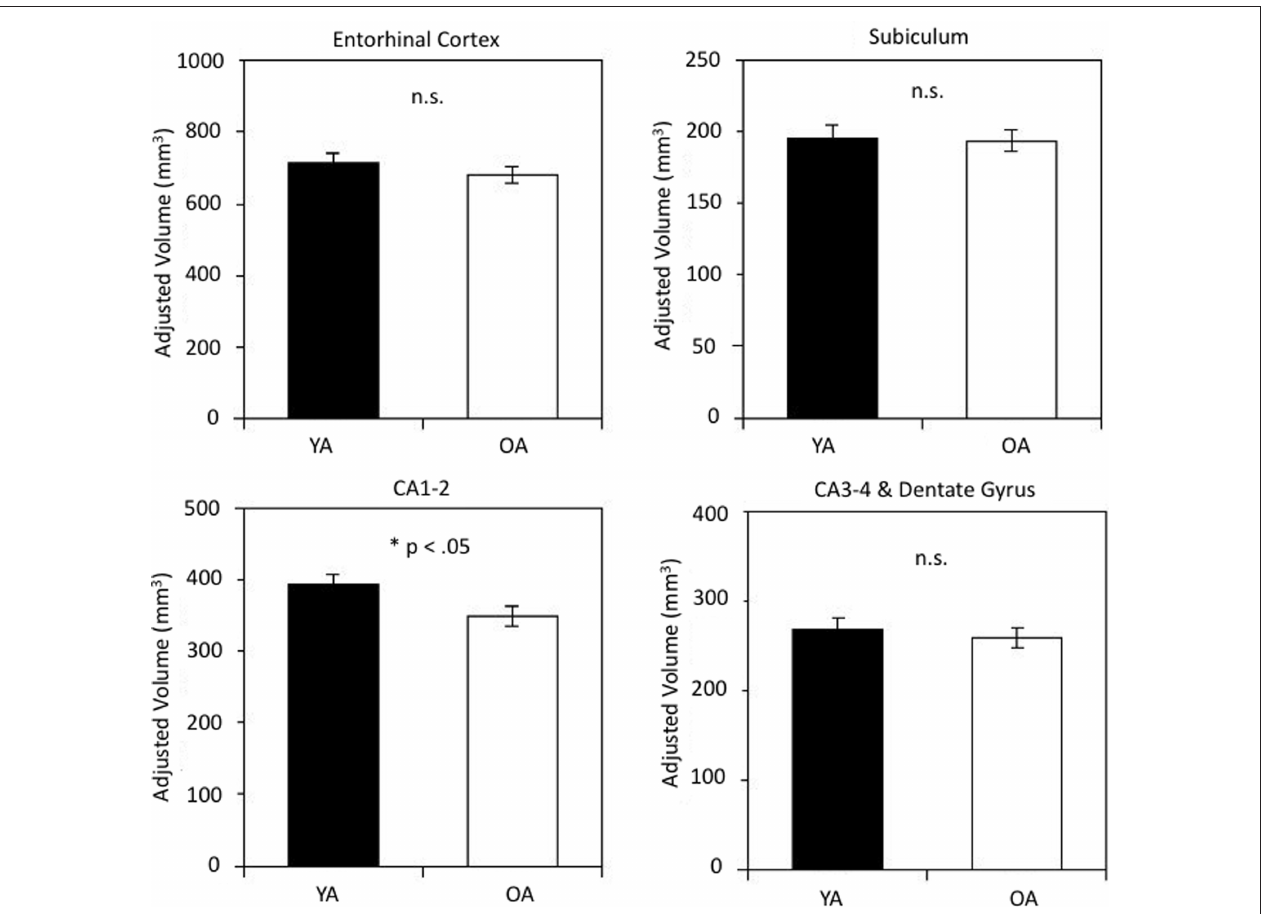
FIguRe 2 | Hippocampal subfield volumes in younger and older adults. Age-group differences in volume were reliable for subfield CA1-2. Volumes are adjusted for intracranial volume (ICV) as detailed in the text. The bars represent SE of the